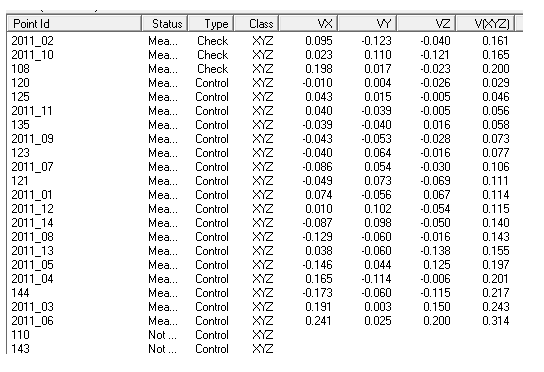
Table 3. Control/Check Points Residuals